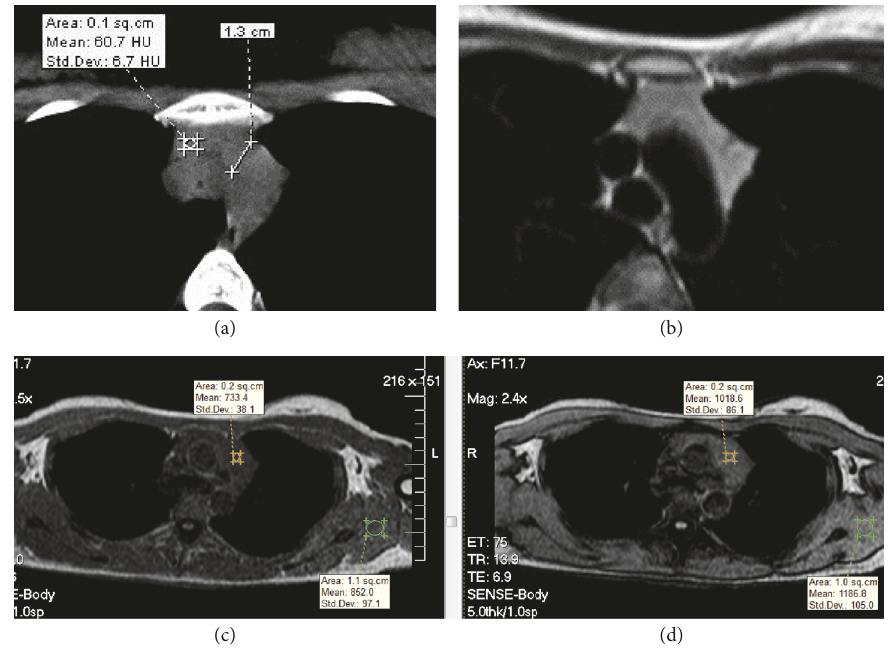
Figure 1: (a) CT image, (b) T2-weighted MRI, and (c) in-phase and (d) opposed-phase images presenting the gland without adipose tissue with CSR 1.0.